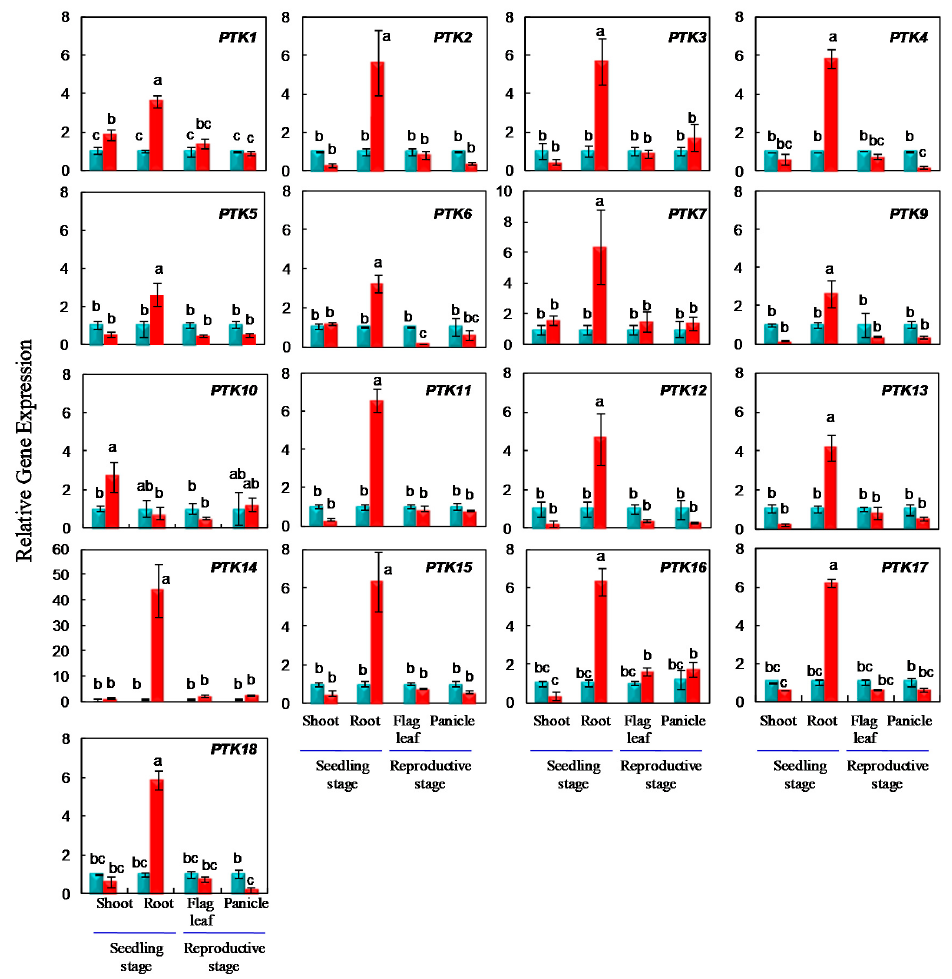
Figure 7. Expression analysis of PTK genes under osmotic stress at seedling stage in hydroponics, and under drought stress at anthesis stage in field conditions in rice. The relative expression was analysed by 2 − ∆∆ ct method. Ct values of control served as calibrator. Bars in blue and red colors represent control and stress treatments, respectively. Small letters a, b, and c represents statistical di ff erence, di ff erent letters indicate significant di ff erences; Error bars indicate SE; n = 3 biological